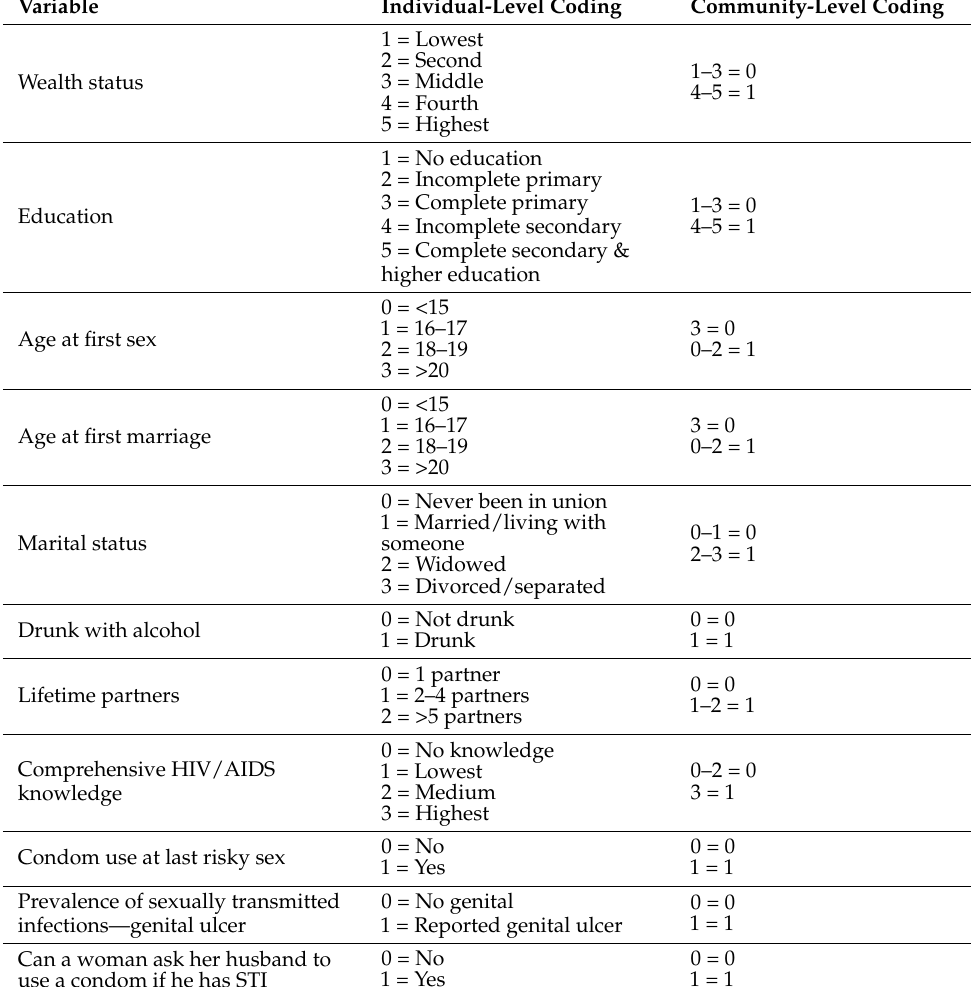
Table A1. Recoding of derived community-level variables for data of UAIS, 2004–2005 and 2011. Variable Individual-Level Coding Community-Level